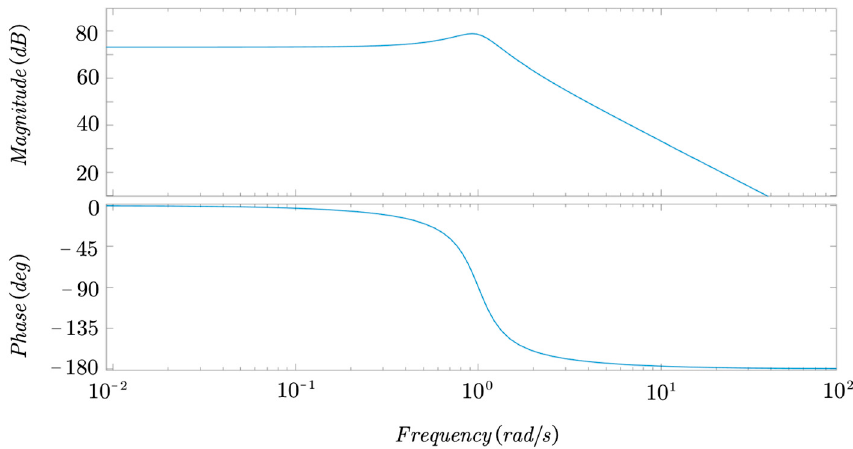
Figure 12. Bode Plot. Figure 12. Bode